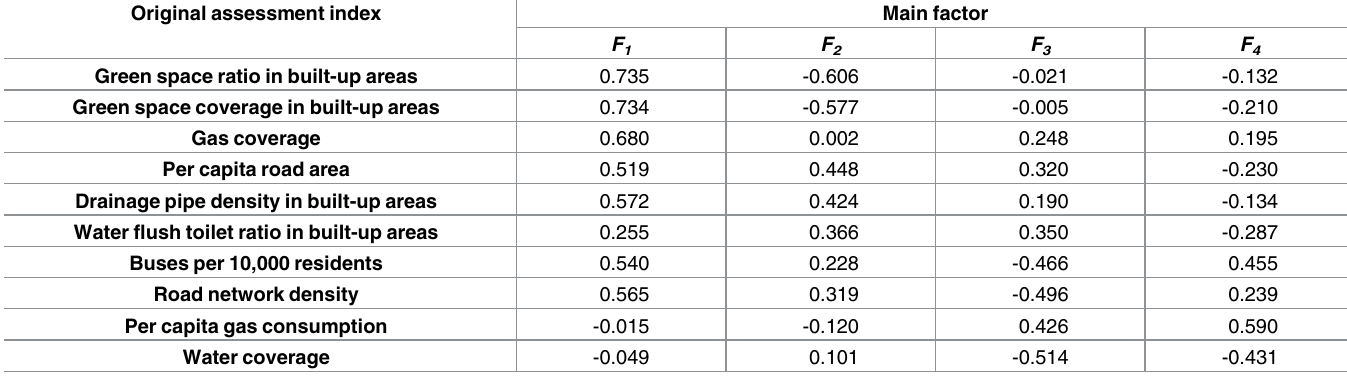
Table 3. Factor loading for comprehensive municipal infrastructure development before